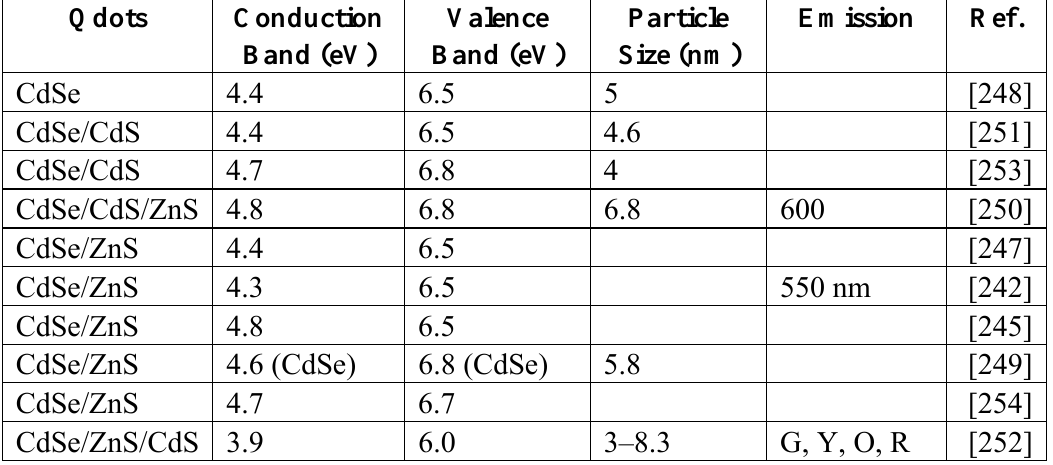
Table 5. Valence band and conduction band energies for different sized and structured CdSe